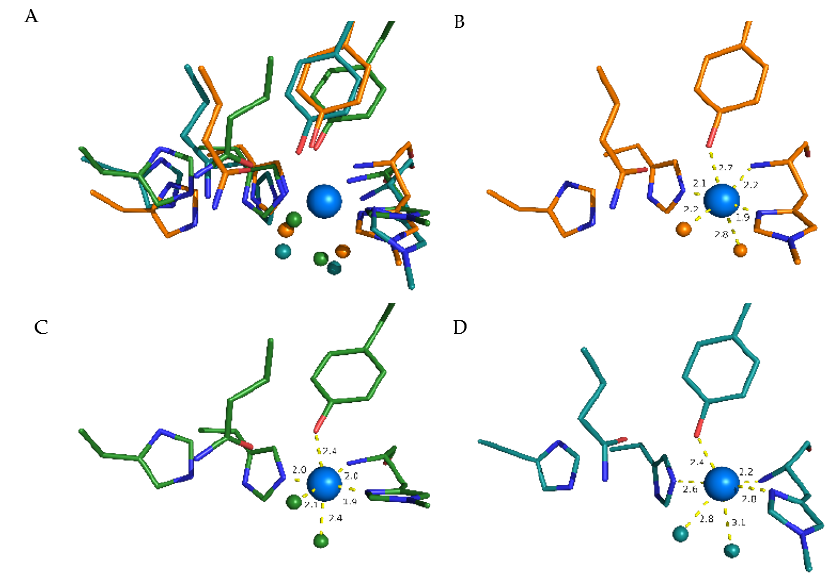
Figure 5. Comparison of active-site geometries regarding water molecules surrounding the copper atom. ( A ) Superimposition of Ls LPMO9A (pdb: 5acg; orange), Nc LPMO9C (pdb: 4d7u; QM-optimized; green) and Nc LPMO9C (clustered from MD Simulation; cyan) structures. ( B – D ) show same structures in a single image, including distances. ( B ) Active site from Ls LPMO9A (pdb: 5acg) crystal structure (orange), ( C ) Nc LPMO9C (pdb: 4d7u) QM-optimized structure (green) and ( D ) clustered structure of Nc LPMO9C from a 200 ns MD-Simulation (cyan). Bigger blue sphere represents copper atom and smaller spheres oxygen atoms of water molecules. The hydrogen atoms of all amino acid residues are hidden.